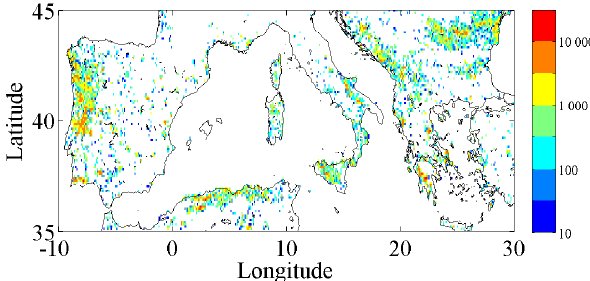
Figure 1. 10-years accumulated burnt area (in ha) from MODIS MDC64 product over the Mediterranean region